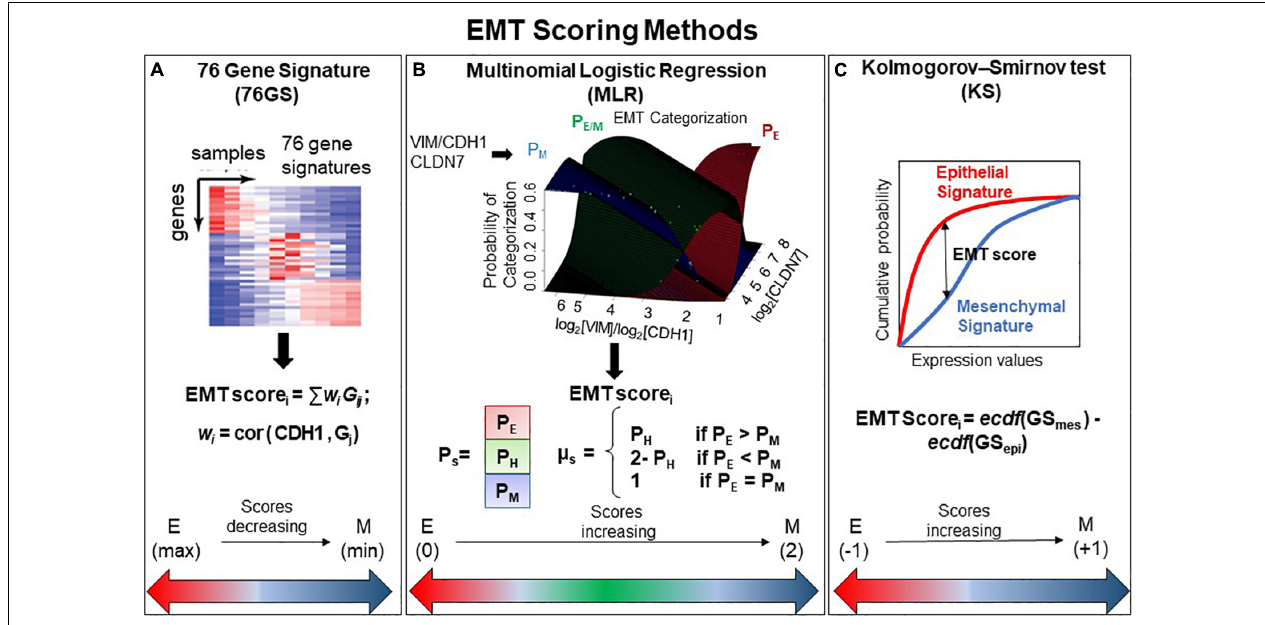
FIGURE 1 | General outline of all three EMT scoring methods. (A) 76GS score is calculated by weighted sum of 76 genes, where EMT score i is score for i th sample, w j is correlation of j th gene ( G j ) with CDH1 gene in that dataset to which the sample i belongs, G ij is the j th gene’s normalized expression in i th sample. (B) MLR utilizes log 2 (VIM)/log 2 (CDH1) and log 2 (CLDN7) space to predict categorization of a sample into E, E/M, or M category. Where P E , P H , and P M are the probabilities of a sample falling into each phenotype. EMT score i is the score for i th sample, which is defined in relation to P E , P H , and P M . Figure adapted from George et al. (2017) with permission. (C) KS score is estimated by the empirical cumulative distributions of epithelial and mesenchymal gene set, denoted by ecdf (GS mes ) and ecdf (GS epi ), respectively. EMT score i is the maximum vertical distance between the ecdf (GS mes ) and ecdf (GS epi ) (given by Eq. 1 in the section “Materials and Methods”) for a given sample i